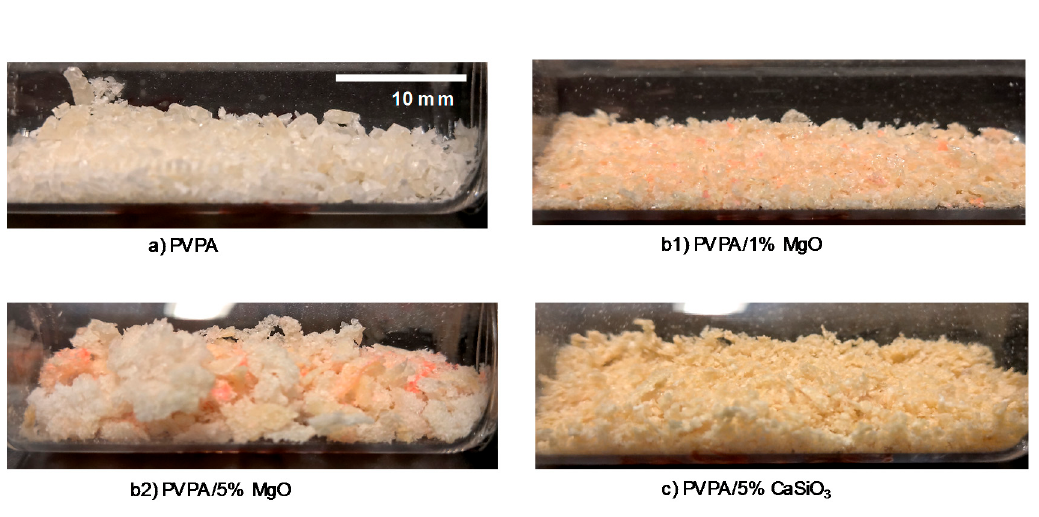
Figure 5. Images of post-water soak remnants of ( a ) PVPA, ( b1 ) PVPA / 1% MgO, ( b2 ) PVPA / 5% MgO and ( c ) PVPA / 5% CaSiO 3 discs.